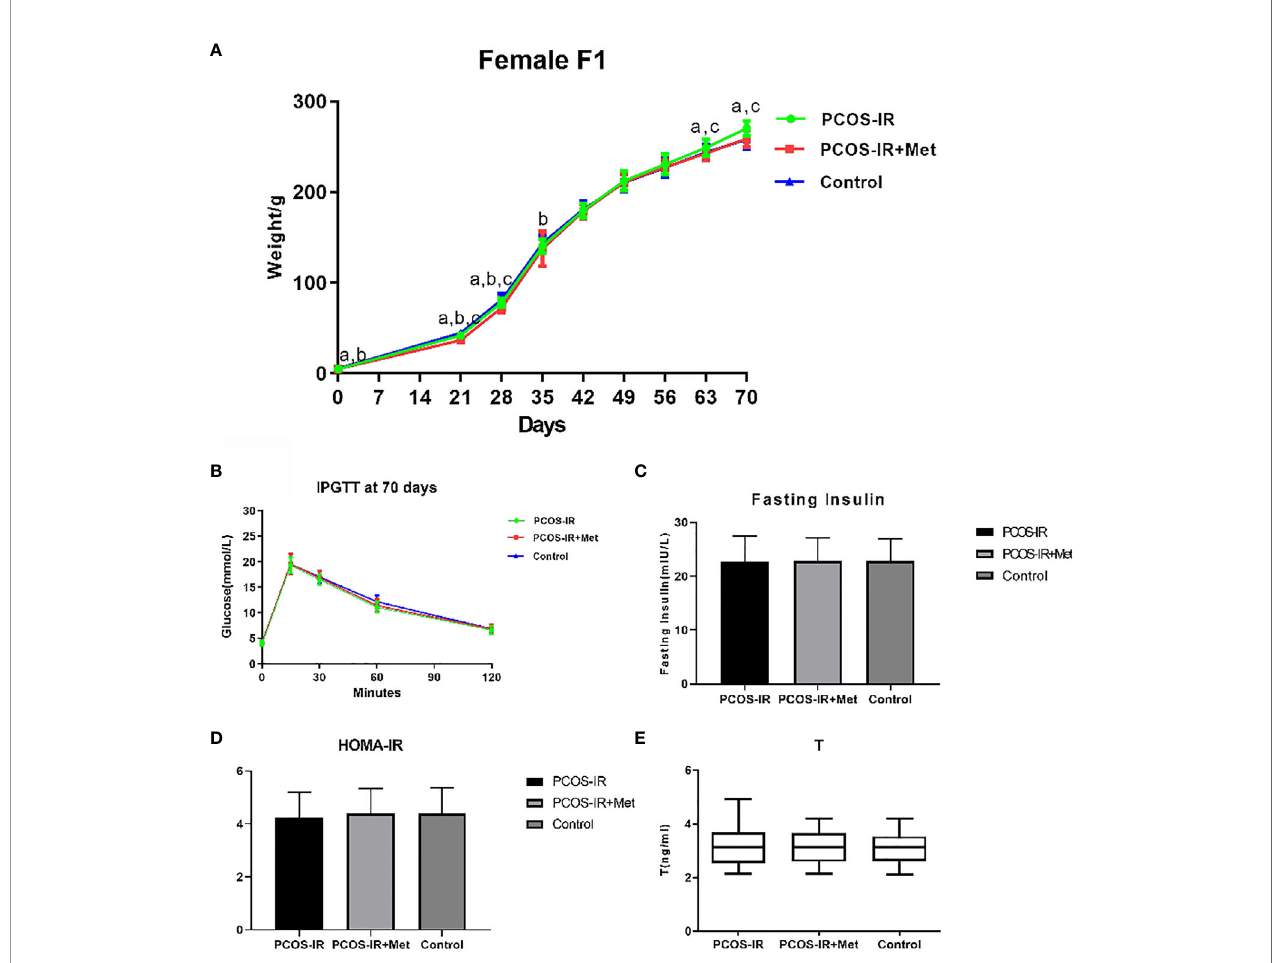
FIGURE 3 | The effects of metformin treatment on the endocrine and metabolic alterations in female F1 offspring. (A) Body weight changes in female F1 offspring (PCOS-IR group, n = 19; PCOS-IR+Met group, n = 48; Control group, n = 46). a P < 0.05 PCOS-IR vs. Control, b P < 0.05 PCOS-IR+Met vs. Control, c P < 0.05 PCOS-IR vs. PCOS-IR+Met, ANOVA; (B – E) Glucose, fasting insulin, HOMA-IR, and T changes in female F1 offspring (PCOS-IR group, n = 19; PCOS-IR+Met group, n = 48; Control group, n = 46). There were no signi fi cant changes during those groups,